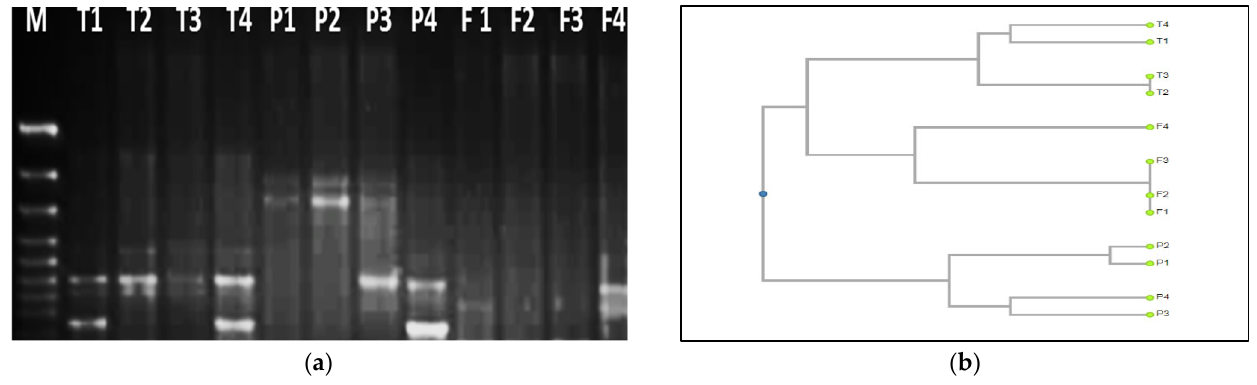
Figure 6. Results of the PCR analysis through the ISSR marker: ( a ) ISSR profiles of studied tree species with ISSR primer UBC 807; ( b ) diagram of the cluster analysis (UPGMA) on the basis of amplified polymorphic bands of experimental saplings in the PCR analysis. CP—cophenetic correlation, CP = 0.895. Legend : M—molecular marker; T— T. tomentosa genotypes; P— P. nigra genotypes; F— F. excelsior genotypes. Numbers 1, 2, 3, and 4 indicate the number of the experimental plot where the saplings were planted.